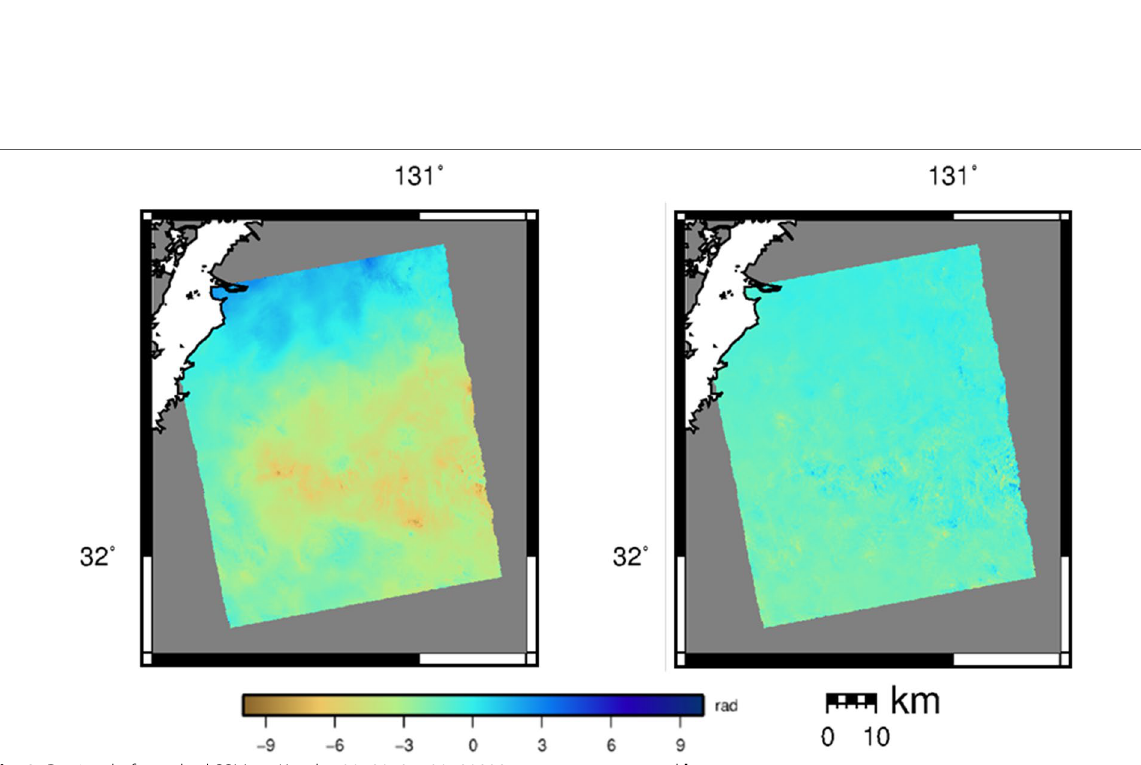
Fig. 3 Retrieval of standard SSM on Kyushu 20180731_20180828. a �φ non-dispersive and b �φ